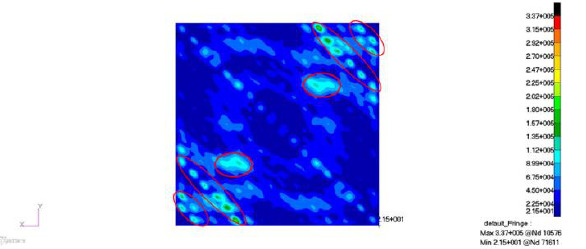
Figure 5. The equal proportion linear summation strain energy of the first 20 modes of the composite plate.